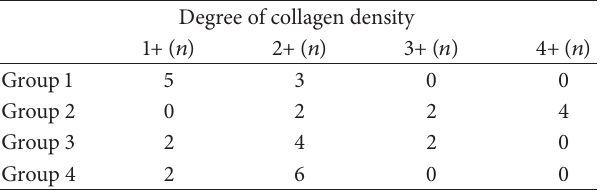
Table 2: Distribution of cavernosal collagen density in the